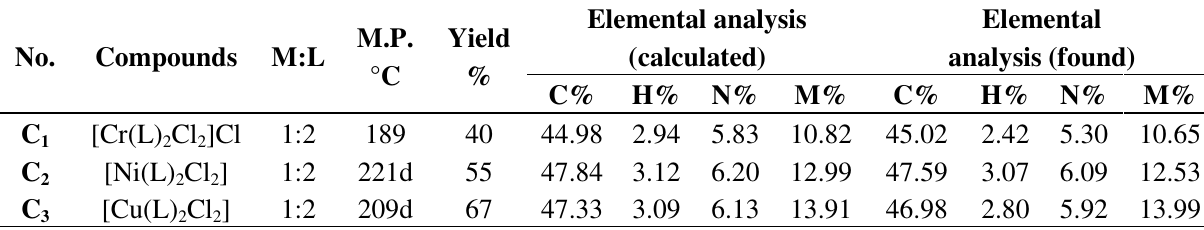
Table 2. Analytical data for the metal complexes.